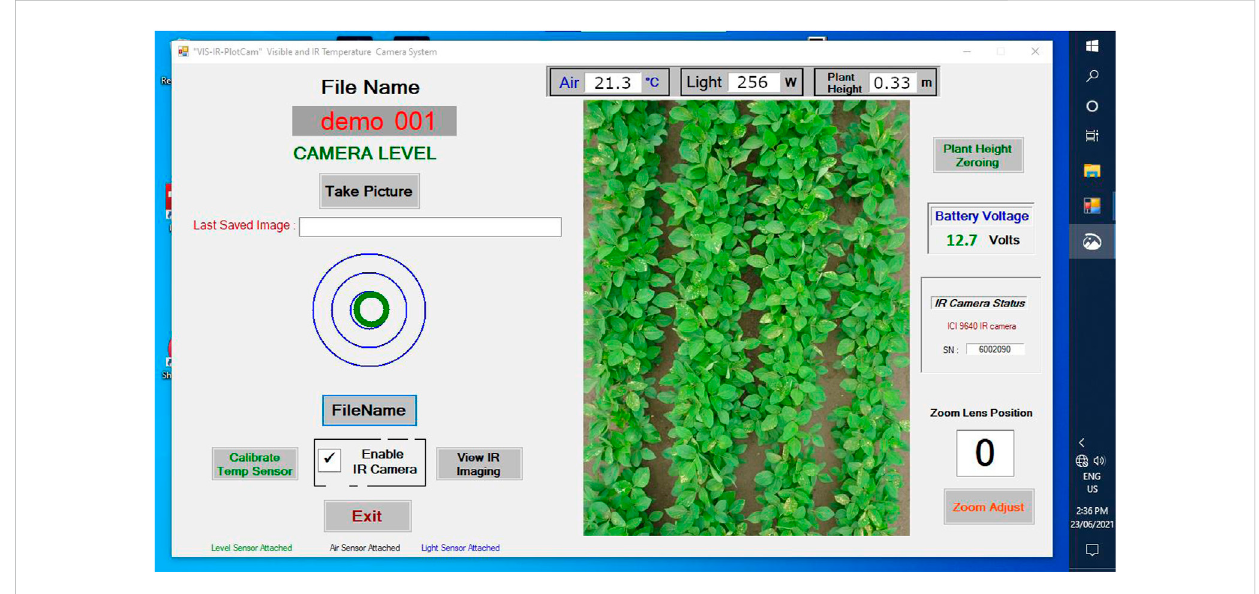
FIGURE 3 View of the main screen of the PlotCam user interface as seen through the headset worn by the